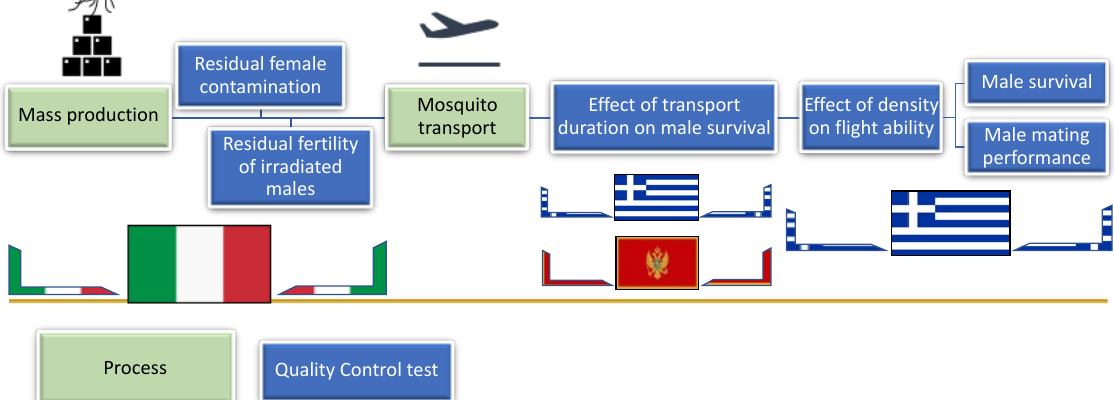
Figure 1. Flow diagram outlining of the processes from mass production to transport and the respective Quality Control (QC) tests performed. The flags of Italy, Greece and Montenegro indicate the activities conducted in respective states.